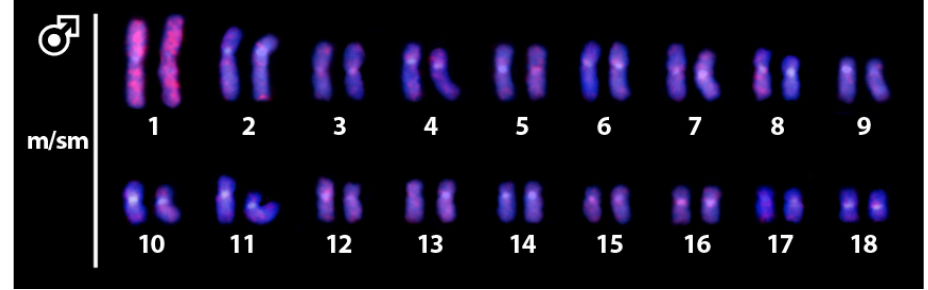
FIGURE 4 | Whole chromosome painting (WCP) highlighting the first chromosome pair of Lebiasina minuta completely hybridized with the probe from the first chromosome pair of L. bimaculata